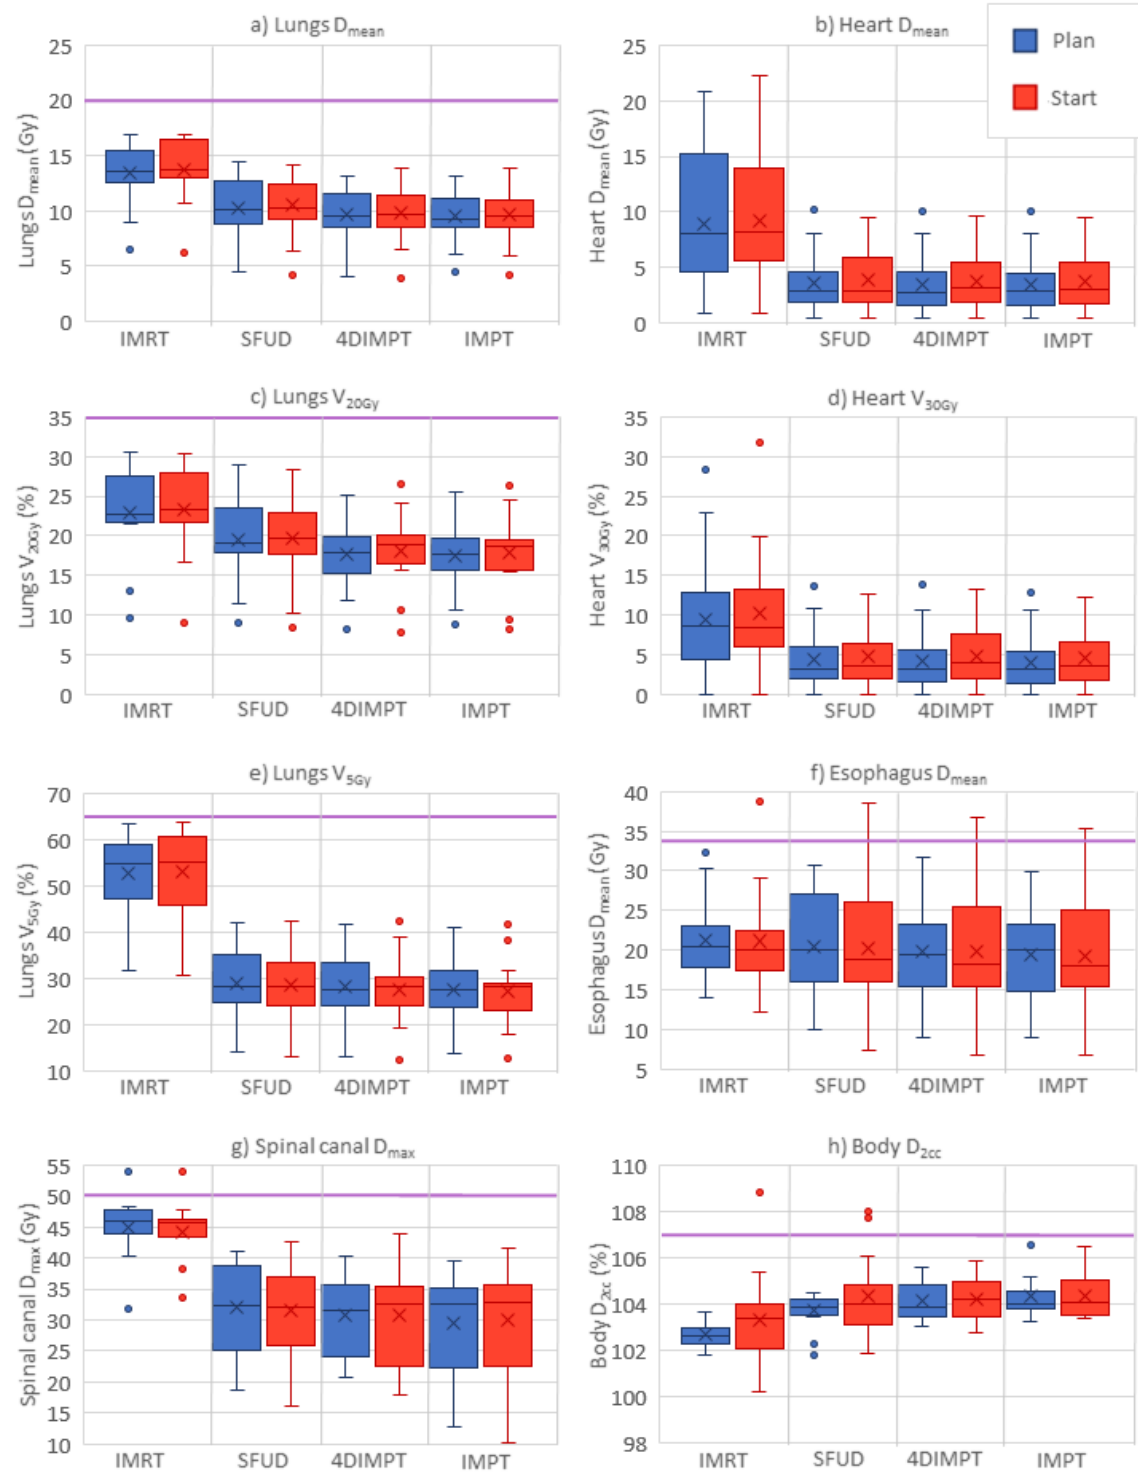
Figure 2. OAR and normal tissue doses at Plan (blue) and Start (red) for the different optimization techniques; panel ( a – h ) shows each of the evaluated parameters. Purple horizontal lines indicate planning constraints in cases where the value is included in the plot. Boxplots show the median (line), mean (cross) and spread, with outliers as dots outside the box. IMRT = intensity-modulated radiotherapy, SFUD = single-field uniform dose, 4DIMPT = 4D robustly optimized intensity-modulated proton therapy, IMPT = 3D robustly optimized intensity-modulated proton therapy.